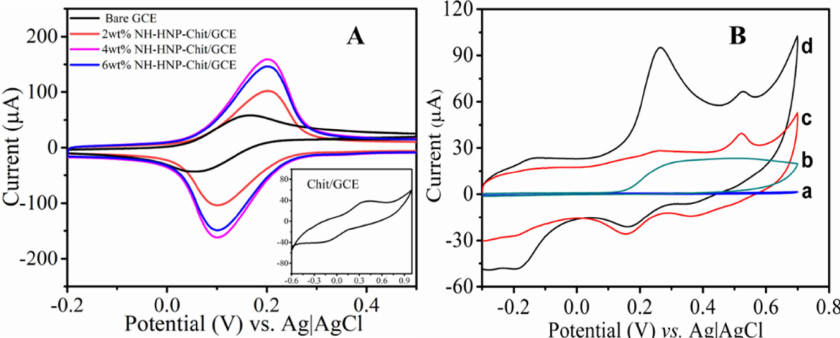
Figure 4. ( A ) Cyclic voltammogram recorded at the bare SPCE, NH-HNP-Chit/SPCE with different Ni(OH) 2 amounts, and Chit/SPCE (inset) in 1 mM K 3 [Fe(CN) 6 ] + 0.1 M KCl. ( B ) Cyclic voltammo- gram recorded at bare SPCE (a, b) and NH-HNP-Chit/SPCE (c, d) in the presence (b, d) and absence (a, c) of 0.5 mM 5-HT in 0.1 M PBS (pH 7.4). Scan rate of 100